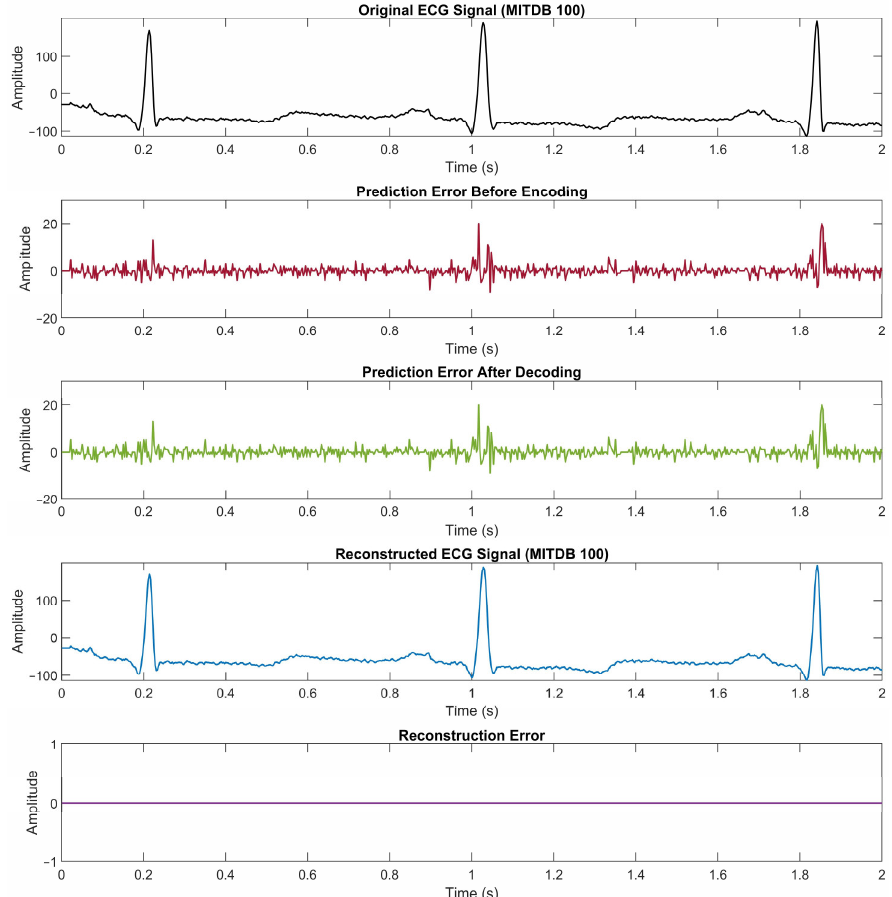
Figure 7. Example of signals in the proposed lossless ECG compression method: original ECG signal, prediction error before encoding and after the decoding process, reconstructed ECG signal, and the reconstruction error for the MITDB record number “100”. To convert the amplitude to millivolts, divide the value by 200.